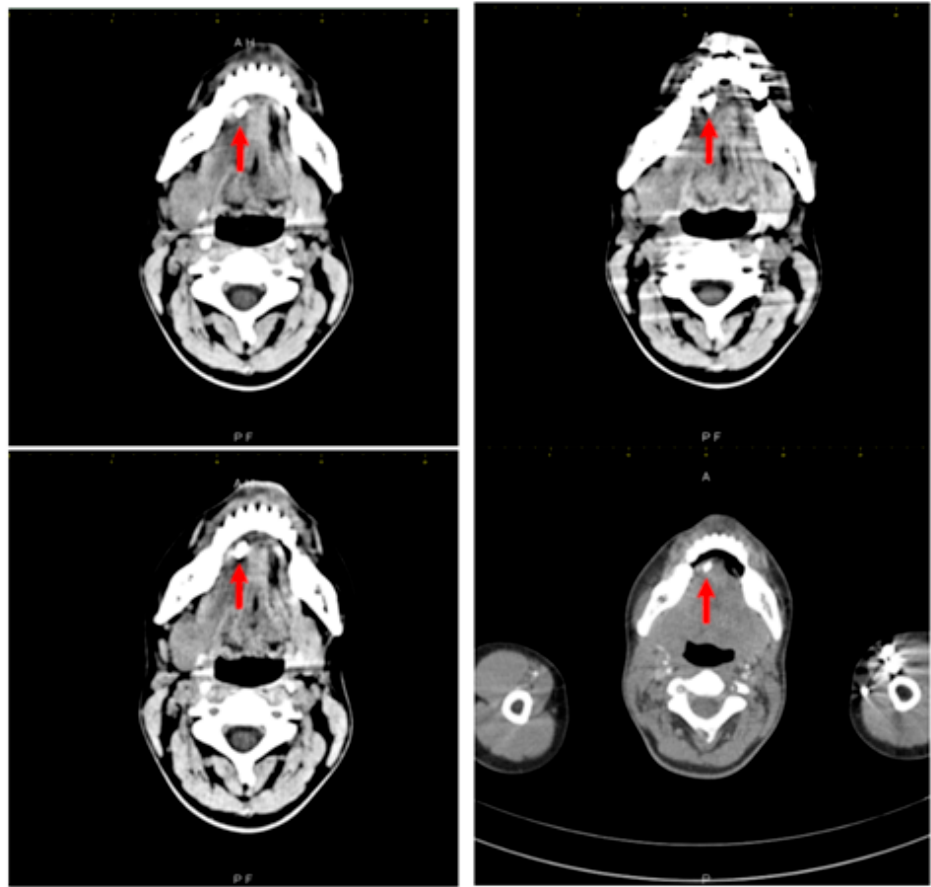
Figure 2. Right submandibular sialolithiasis, various CT scan sections.